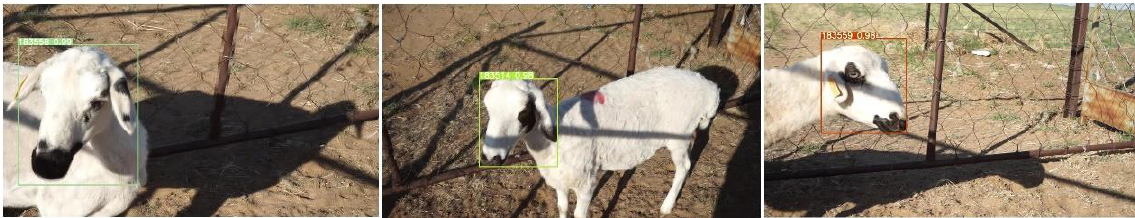
Figure 10. Recognition result. Table 1. Comparison of different network detection